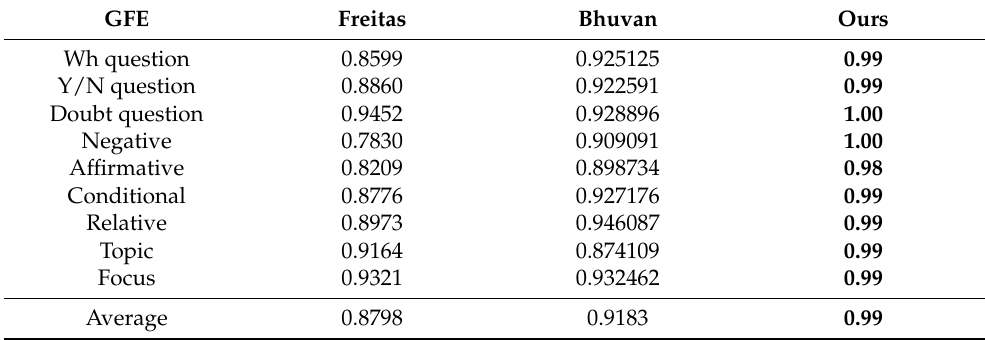
Table 6. F1 scores achieved by our proposed model and other state-of-art approaches using a dataset storing grammatical facial expressions of the Brazilian sign language (Libras) made by subject one and subject two. Best results are in